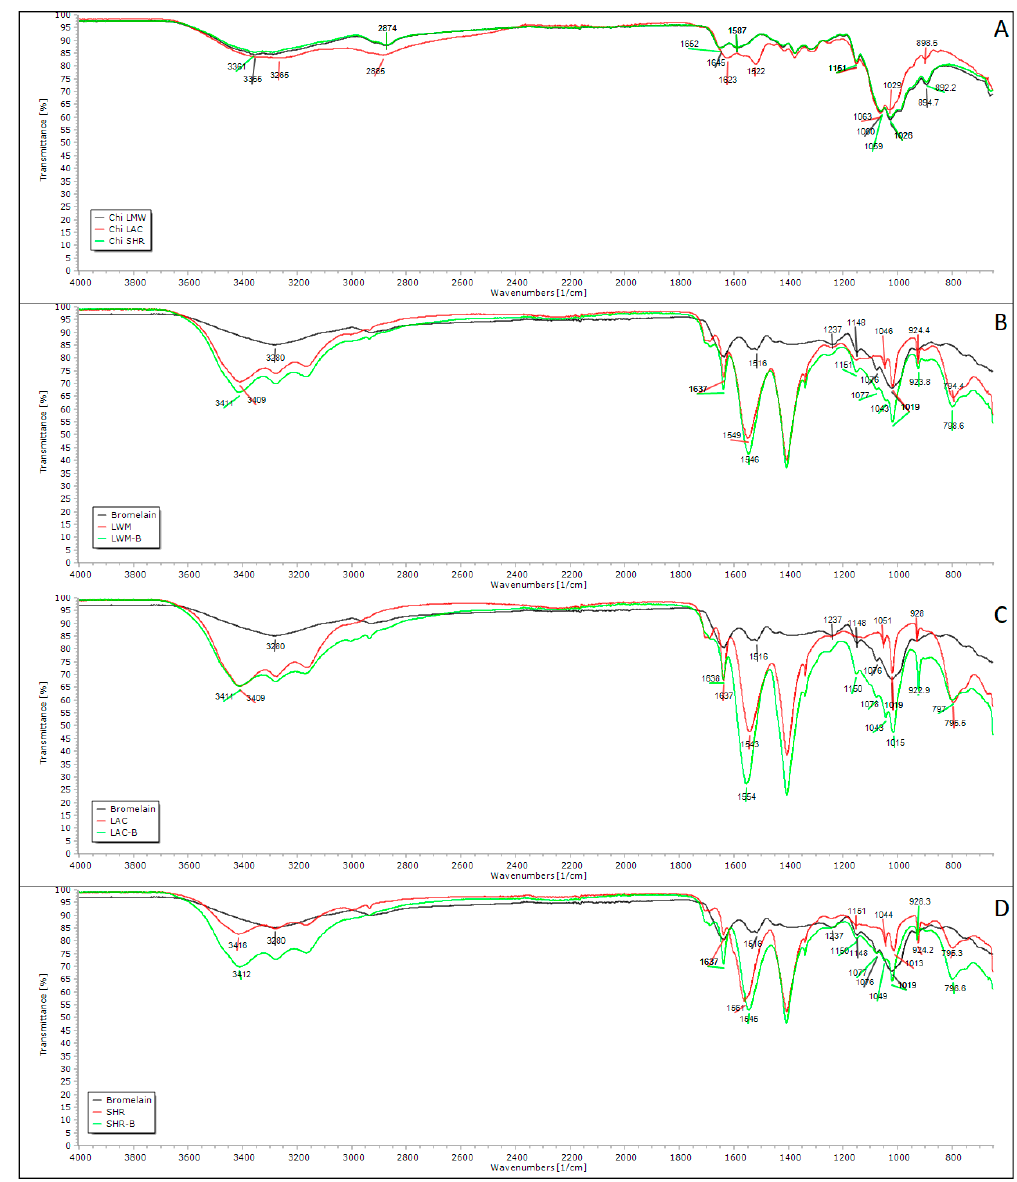
Figure 3. Fourier transform infrared spectra of different types of chitosan ( A ) and nanoparticles prepared with low molecular weight ( B ), oligosaccharide lactate ( C ) and from shrimp shells ( D ) chitosan. LMW = low molecular weight chitosan nanoparticles; LAC = chitosan